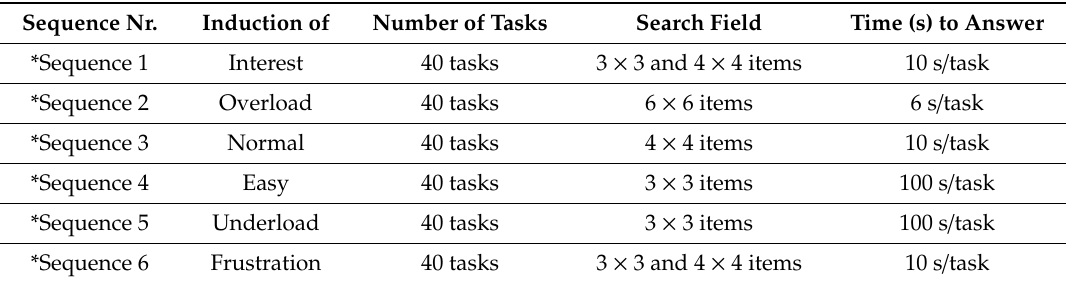
Table 1. Illustration of the experimental procedure and sequences description.